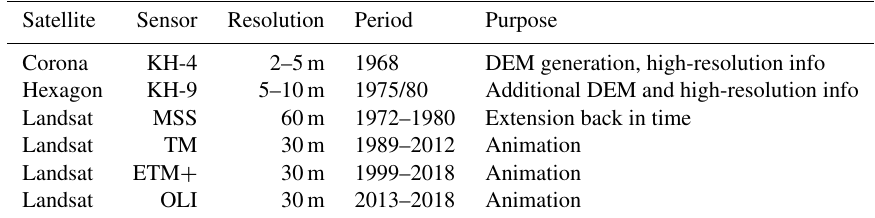
Table 1. Main characteristics of the satellite scenes used (see Table S1 for scene